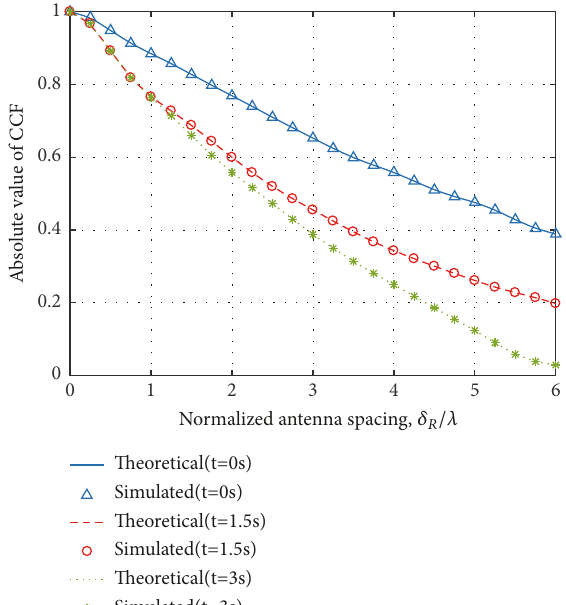
Figure 10: Absolute values of the theoretical and simulated TV-CCF |𝜌 𝑝𝑞,𝑝 󸀠 𝑞 󸀠 (𝑡, 𝛿 𝑅 )| at different time instants ( 𝐾 𝑝𝑞 = 0).